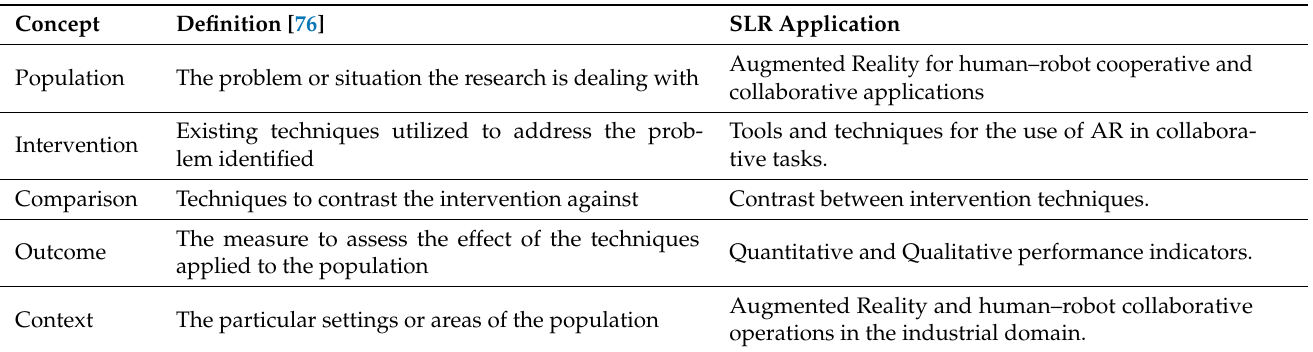
Table 3. Adopted PICOC